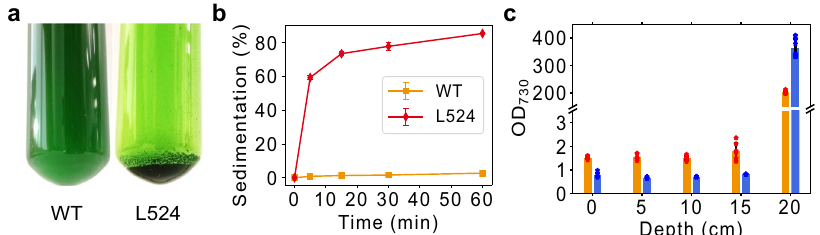
Fig. 4 Evaluation of Aggregation-based sedimentation (ABS). L524 cells after 1-h sedimentation are shown in a , with wild-type as control. By monitoring the sedimentation process, we found L524 cells started to settle within 5 min and over 75% cells were settled after 15 min ( b ), suggesting the high settling velocity of ABS. Vertical cell concentration analysis suggests that 85% and 93% cells settled to the bottom of the harvesting vessel (20 cm in depth) within 30 min and 6 h, respectively ( b ). Moreover, the biomass concentration at the bottom reaches 357 OD (139.2 g/L), which delivers 14% solids content as an output for ABS ( c ). Original data points of bar fi gures ( b , c ) are shown on the plot with red (0.5 h) or blue (6 h) stars. Data are presented as mean values ±standard deviations ( n = 3 independent samples with two technical replicates). Source data are provided as a Source Data fi